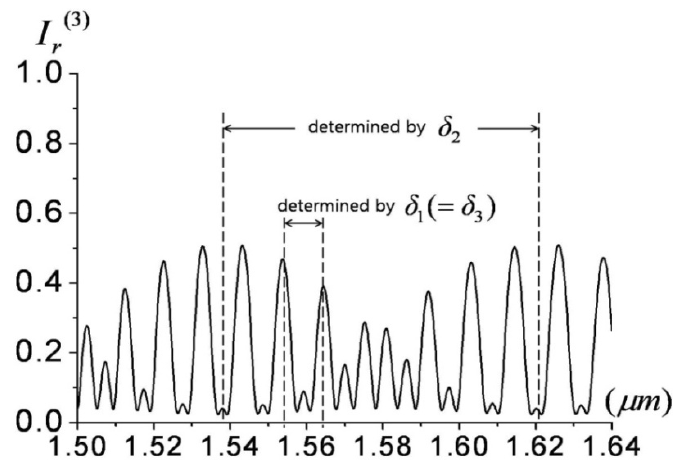
Figure 9. Simulated reflectance fringes for the probe of Figure 8, where  the phase retardances due to layers 1, 2, and 3, respectively